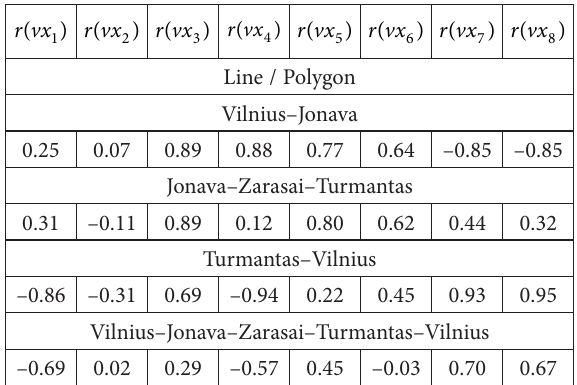
Table 2 . Findings of the correlation analysis